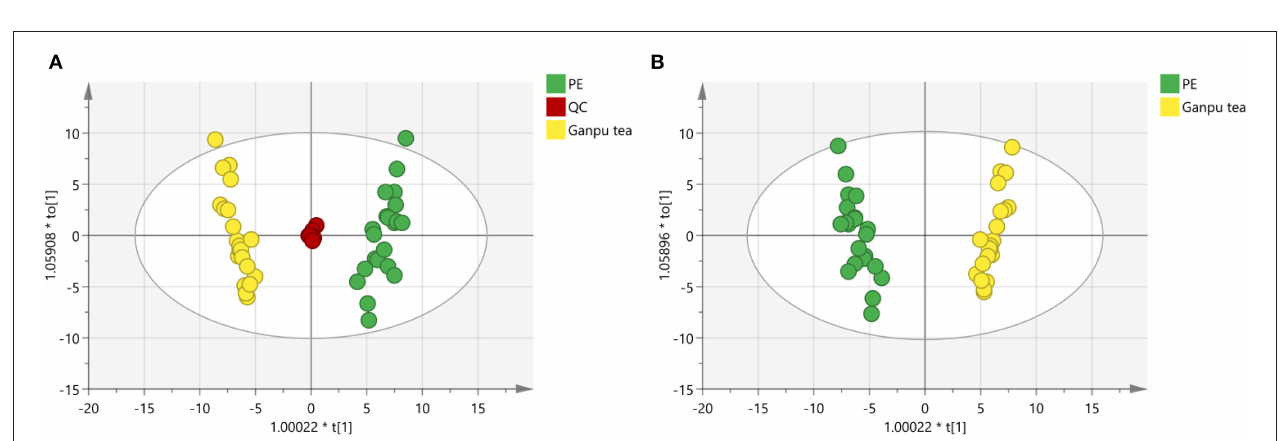
FIGURE 6 | OPLS-DA analysis of 67 features: (A) Score plot of orthogonal partial least squares analysis of PE, Ganpu tea, and QC samples ( R 2 X = 0.805, R 2 Y = 0.560, Q 2 = 0.556). (B) Score plot of orthogonal partial least squares analysis between PE and Ganpu tea ( R 2 X = 0.809, R 2 Y = 0.975, Q 2 = 0.970). Green circles represent Pu-erh tea samples, yellow circles represent Ganpu tea samples, and red circles represent quality control (QC)